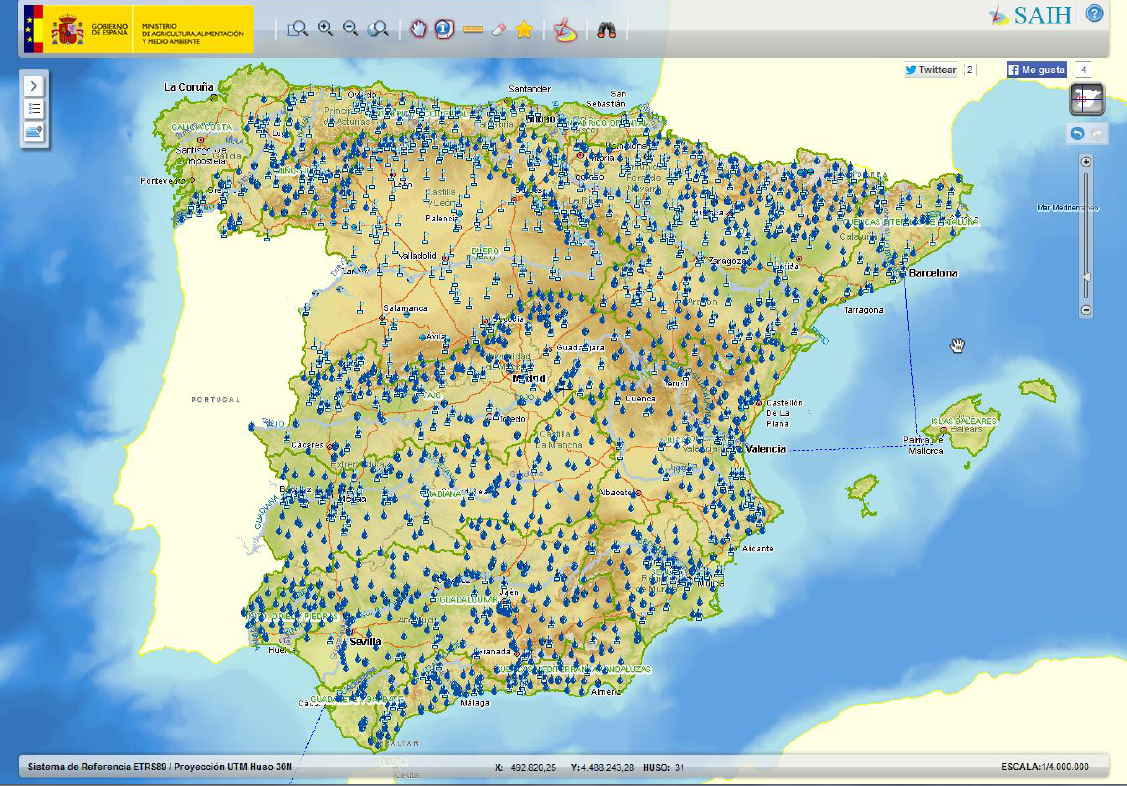
Figure 1. Geographic distribution of the national hydrological sensor network SAIH (part of the network shown by the website of the Ministry of Environment of